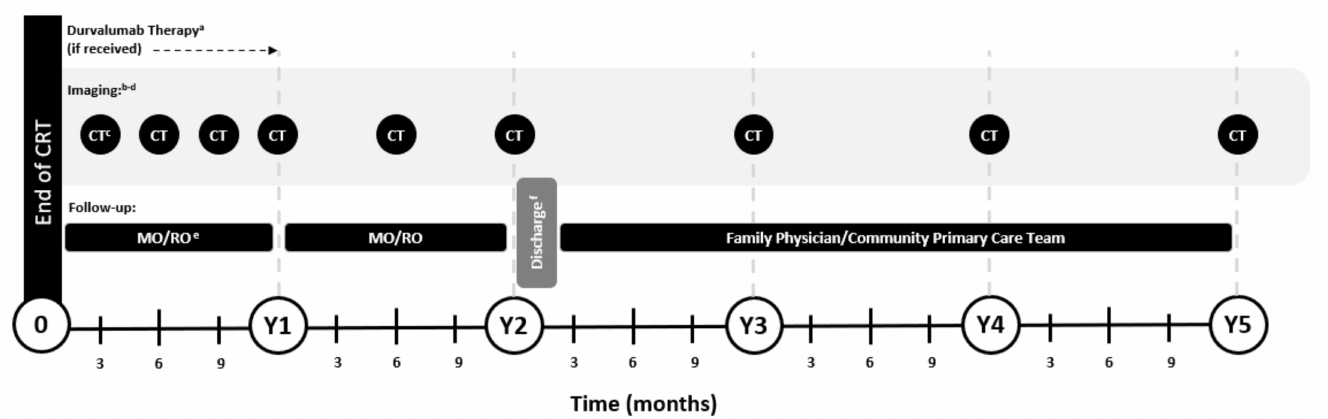
Figure 2. Recommendations for imaging and follow-up of patients with stage III, unresectable NSCLC after treatment with CRT ± durvalumab. Please refer to the text and Table 1 for additional considerations and caveats. a Durvalumab is approved for 1 year of consolidation therapy for patients who have not progressed after CRT; duration of therapy may vary depending on patient response and toxicity. b Baseline imaging is required after CRT and prior to durvalumab initiation to verify that NSCLC has not progressed. Imaging should occur Q3M until durvalumab therapy is stopped. c All CTs are chest/abdomen with contrast (if tolerated) through Year 5. d Baseline brain MRI should be completed in staging work-up before CRT. Subsequent brain imaging is only recommended in the event of symptom presentation; a low threshold of suspicion should prompt assessment. MRI is preferred over CT, if an option. e In Year 1 of durvalumab therapy, the RO (and possibly respirology) should be involved if associated pneumonitis is suspected; the MO and RO should alternate follow-up in Years 2 and 3 and throughout Years 1 to 3 for non-durvalumab patients. f Suitable patients only, see full text. CRT, chemotherapy + radiation therapy; CT, computed tomography; MO, medical oncologist; MRI, magnetic resonance imaging; NSCLC, non-small cell lung cancer; Q3M, every three months; RO, radiation oncologist; Y,